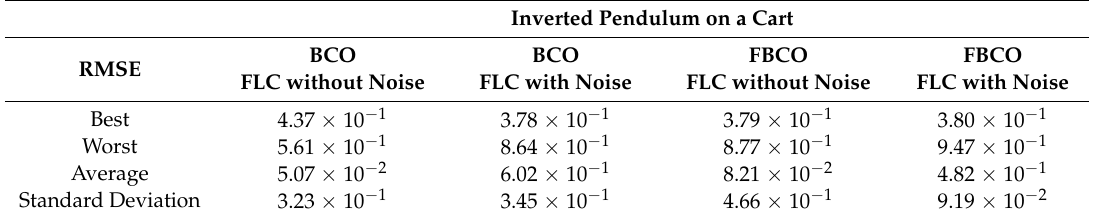
Table 7. Results obtained from the inverted pendulum controller by BCO and FBCO algorithms.